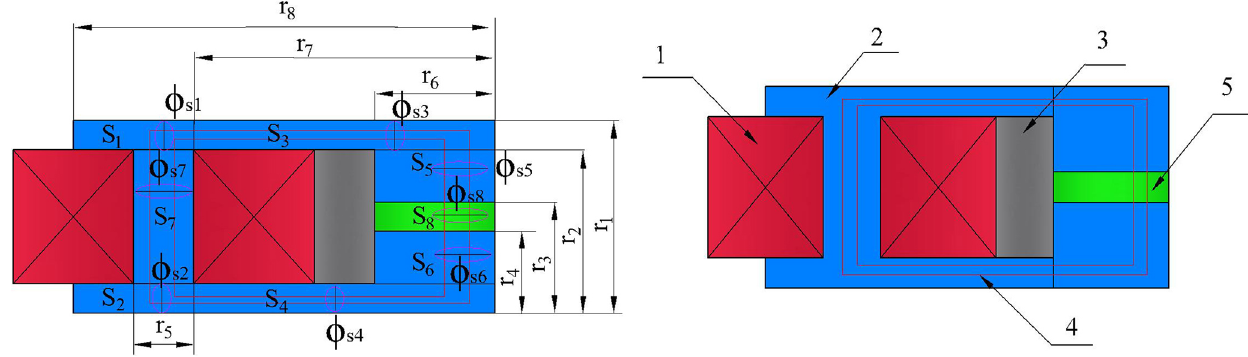
Figure 4. Structure and structural parameters of the magnetic core assembly. 1 is coil, 2 is core, 3 is magnetic spacer, 4 is magnetic flux line, and 5 is the controllable channel.